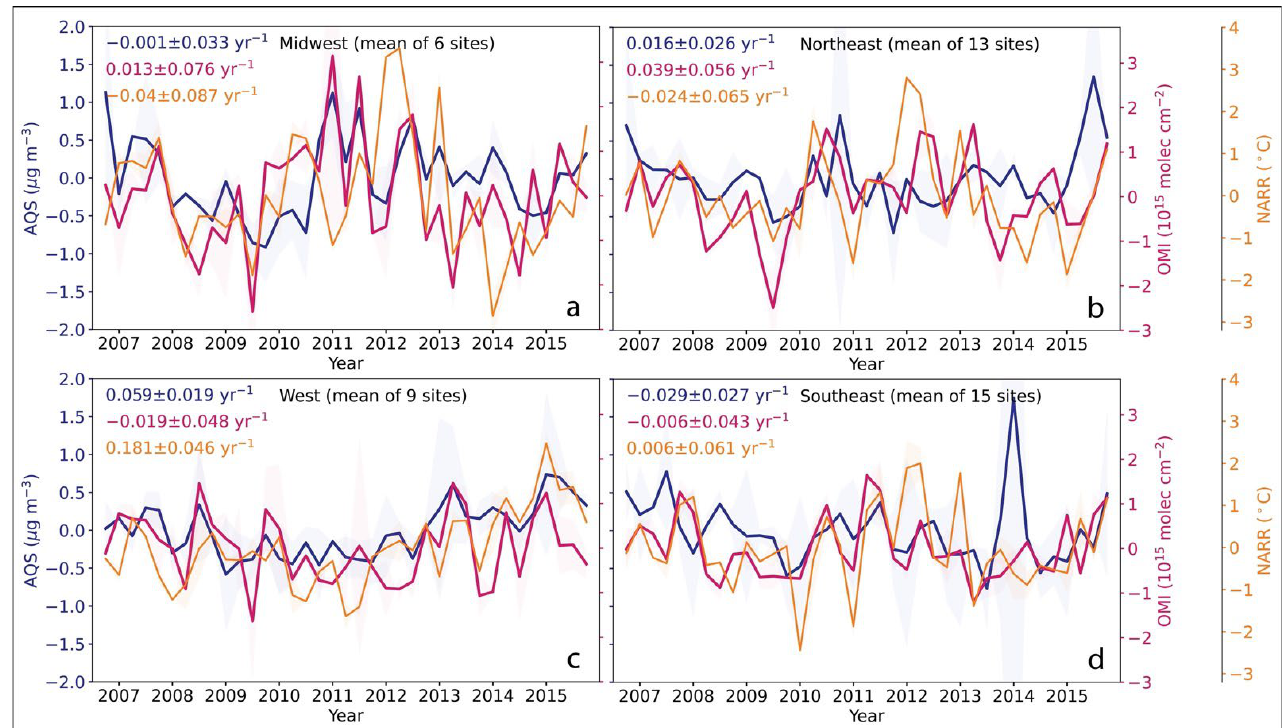
Figure 5. 2006–2015 AQS and OMI HCHO deseasonalized interannual trends averaged by season in the ( a ) Midwest, ( b ) northeast, ( c ) west, and ( d ) southeast. Blue lines indicate AQS trends, red lines represent OMI trends, and yellow represents 2 m temperature from the North American Regional Reanalysis (NARR) data, sampled at the AQS monitor locations. Solid lines are the mean seasonal HCHO abundance or temperatures, and shaded areas are the standard deviation. Region name and number of stations in the region are labeled at the top of each figure, along with the slope of the line of best fit and the standard errors associated with the slopes.